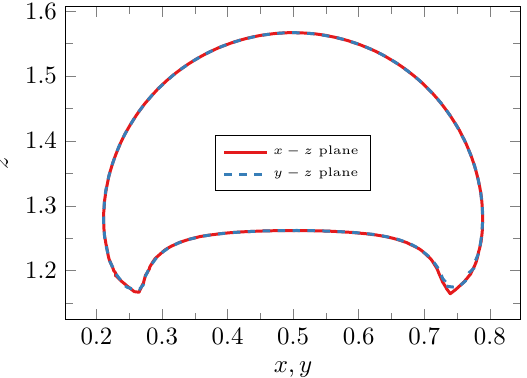
Figure 8. Shape at final time in the x - z and y - z planes for test case 2 ( h =